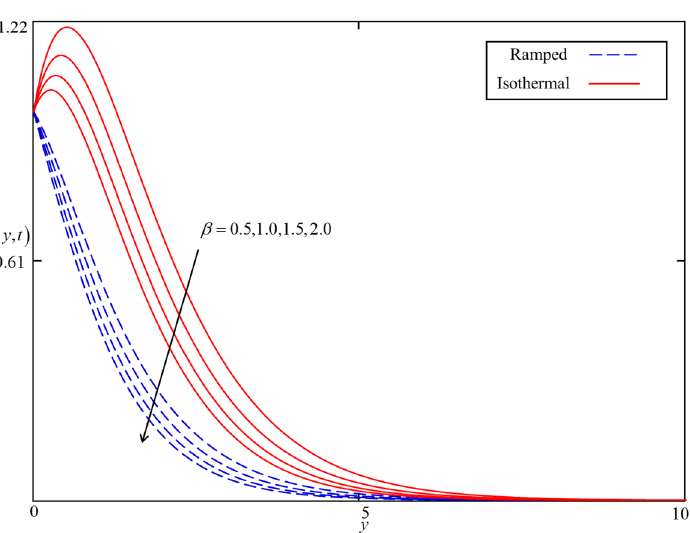
y , t when α = 0.5 , φ = 0.04 , M = 0.5 , Gr = 5 , Nr = 0.5 , and ω t = 0.15 in (cid:30) (cid:31)